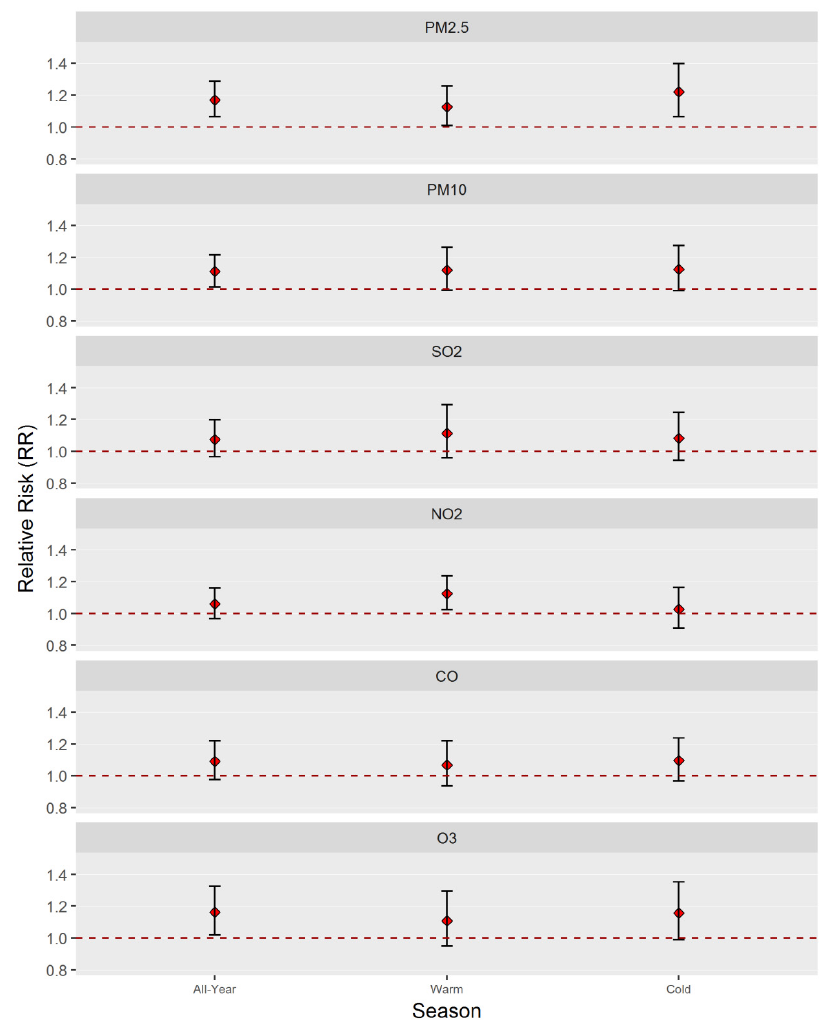
Figure 3. Relative risks (and 95% CIs) of TB incidence associated with an increase of 10 μ g/m 3 in air